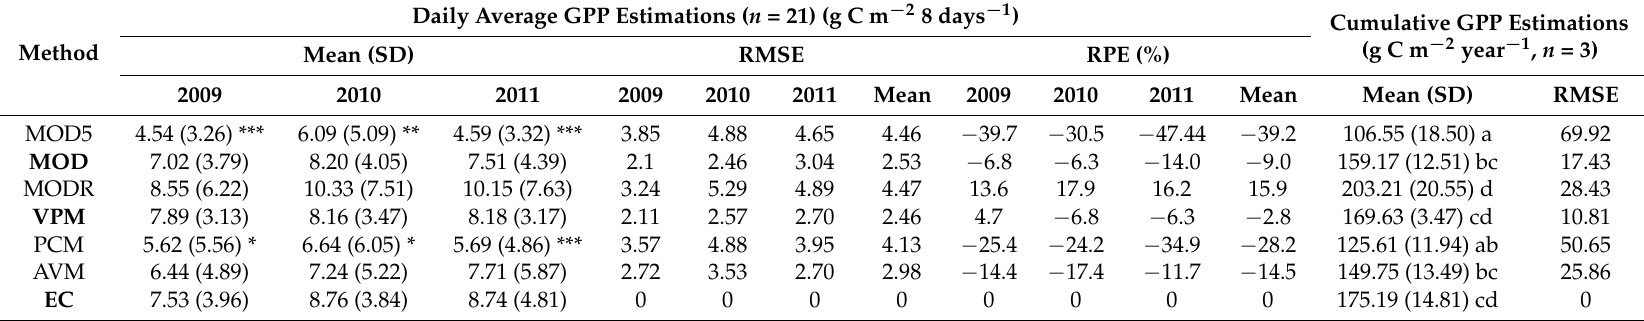
Table 2. Satellite-based gross primary production (GPP) estimations and comparison with tower-based GPP observation during growing seasons from 2009 to 2011.